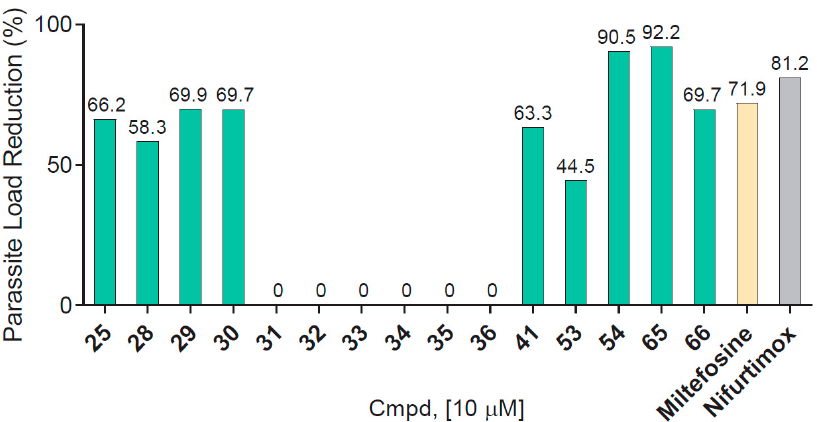
Figure 4. In vitro evaluation of activity against T. cruzi Y strain intracellular amastigotes.